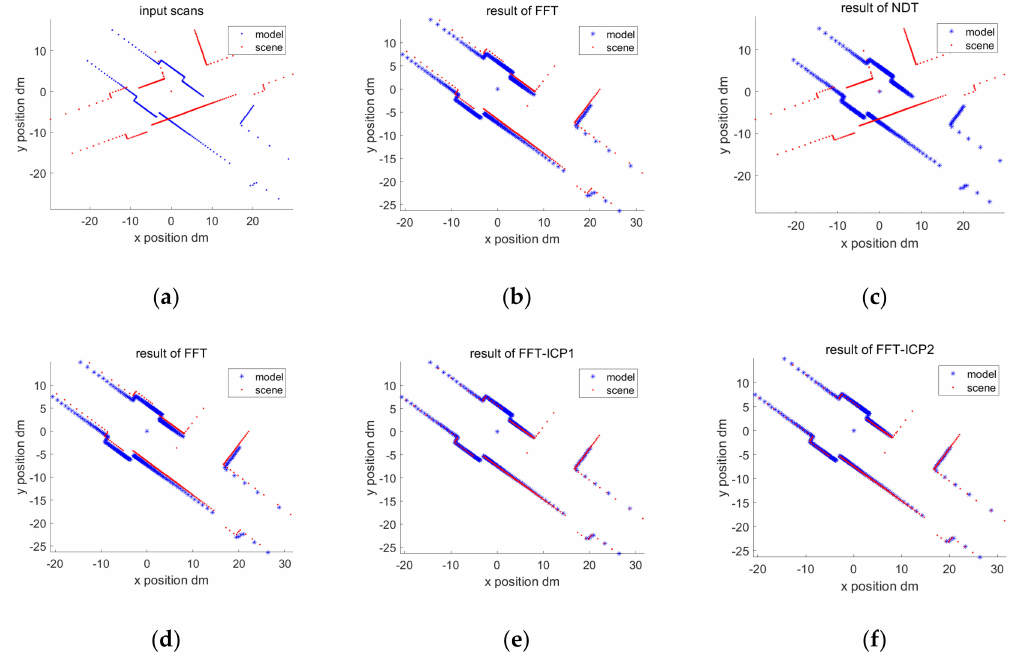
Figure 9. Example of matching results via different methods. ( a ) The input scans; ( b ) the result of ICP; ( c ) the result of Normal Distributions Transform (NDT); ( d ) the result of FFT; ( e ) the result of FFT-ICP1 (original); and ( f ) the result of FFT-ICP2 (current paper).